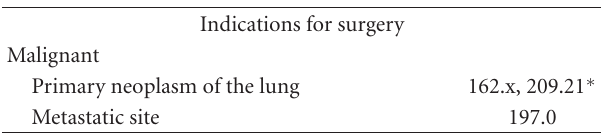
Table 8: ICD-9 codes for index diagnosis. Indications for